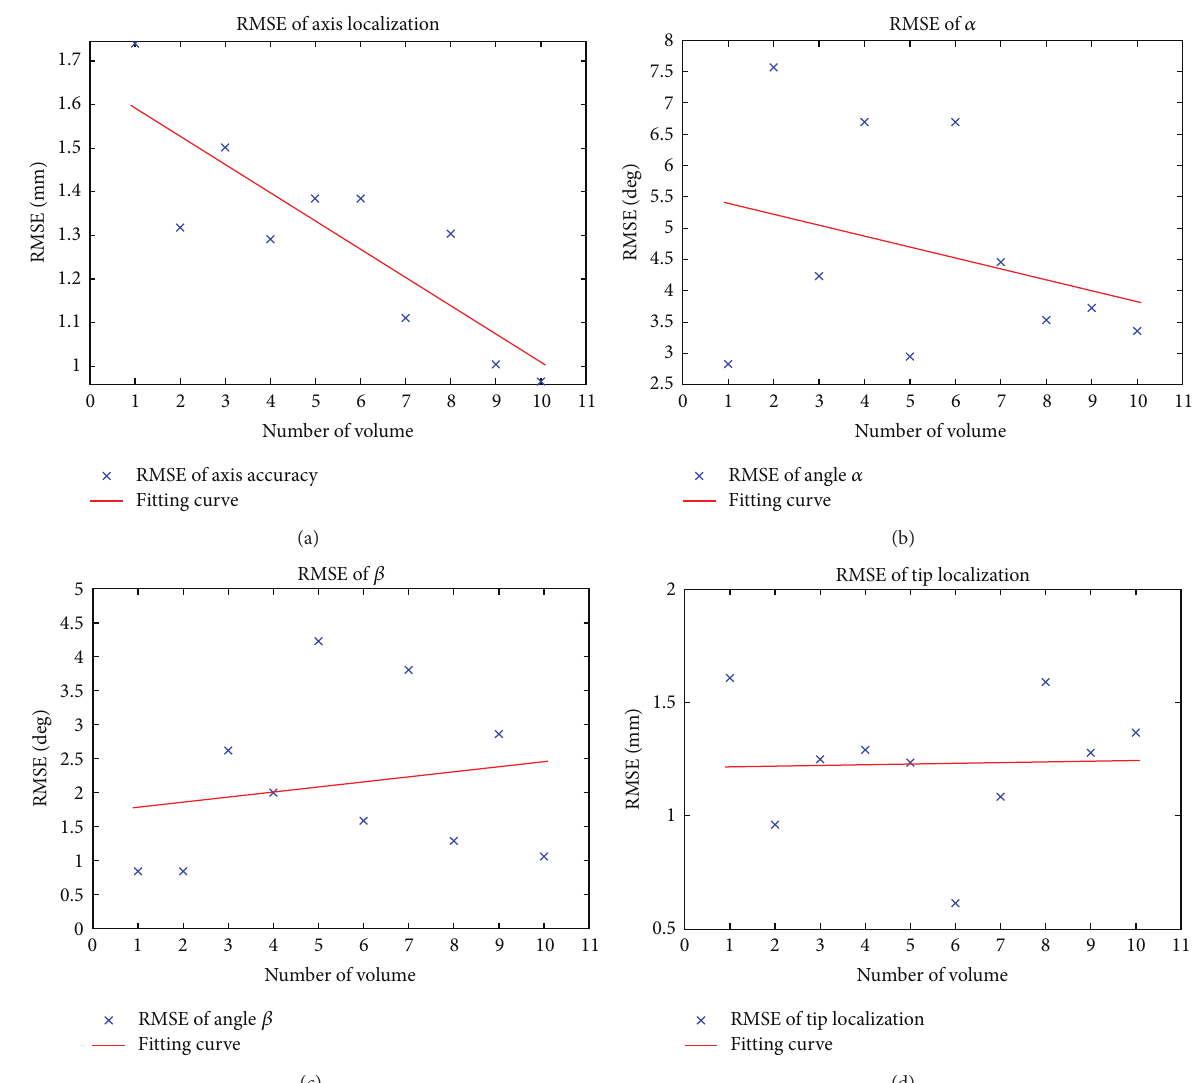
Figure 5: The RMSE of axis accuracy and angles 𝛼 , 𝛽 and the tip position and their fitting